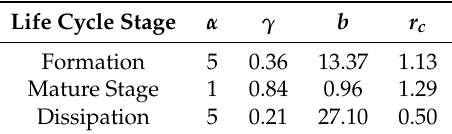
Figure 8. Fitted MGDs to stage-averaged spectra over all three fog events. Table 3. MGD parameters of stage-averaged